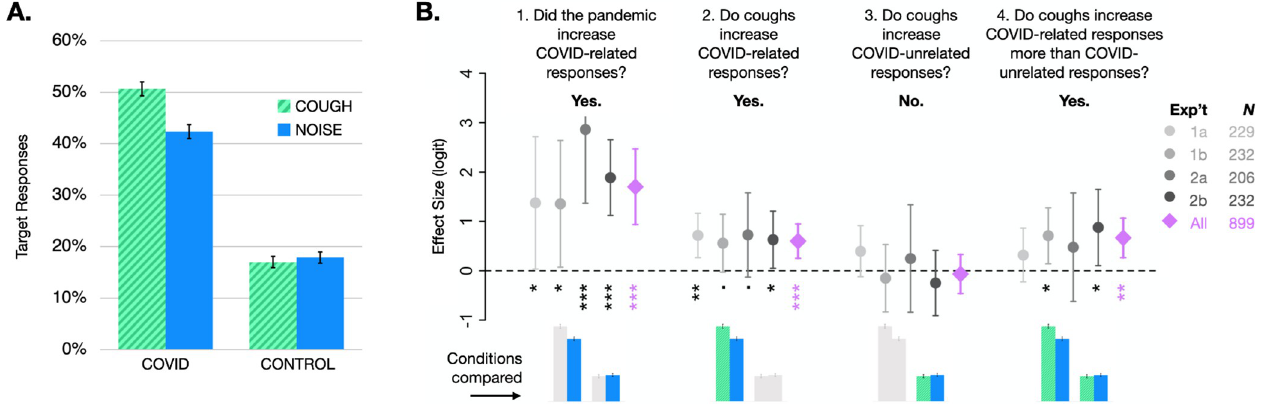
Fig 2. Results for all experiments. (A) Cross-experiment (pooled) condition means and standard errors. (B) Effect sizes and 95% confidence intervals for the four comparisons of interest for each experiment (grey circles) and data from all experiments combined (pink diamonds). Colored bars below refer to (A) and show which conditions are involved in each comparison. Asterisks denote significance ( ��� p < .001, �� p < .01, � p < .05, and “.” p < .10).